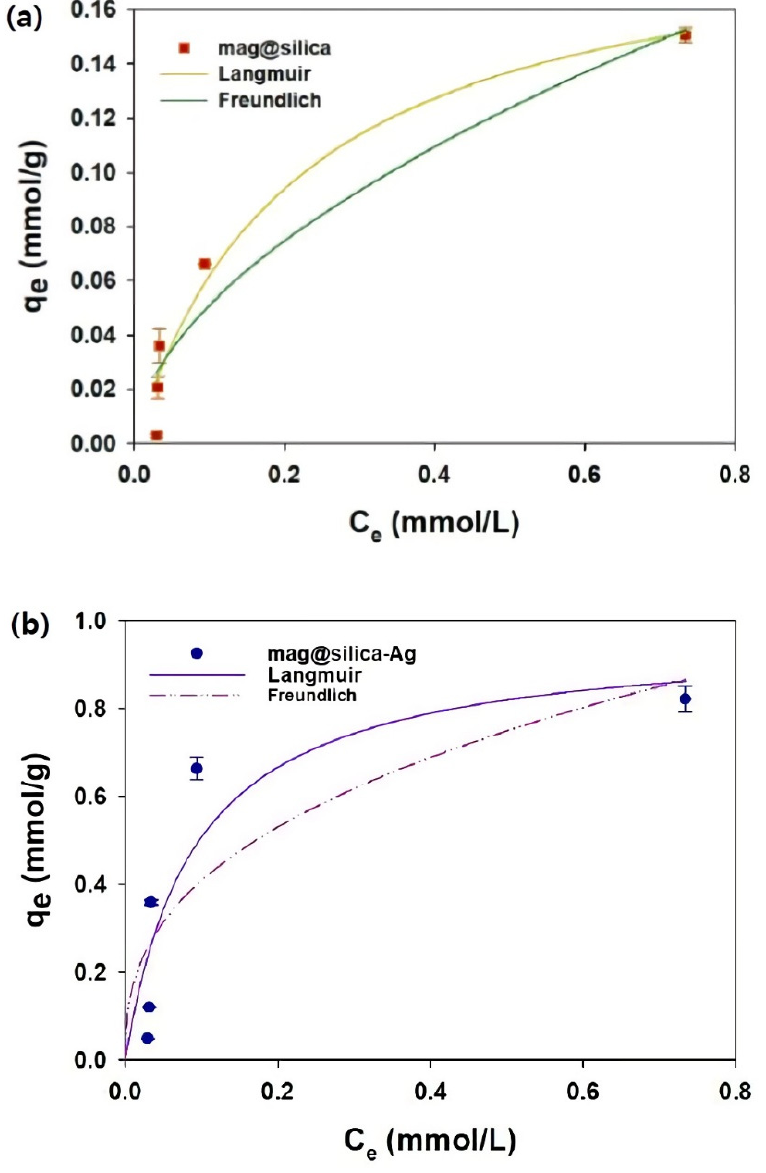
Figure 11. Sorption isotherm of I − on ( a ) mag@silica and ( b ) mag@silica-Ag composite. Adsorbent 0.01 g, I − solution 10 mL, 24 h, 25 °C. Table 4. Langmuir and Freundlich isotherm parameters for the adsorption of I − onto mag@silica and mag@silica-Ag. Langmuir